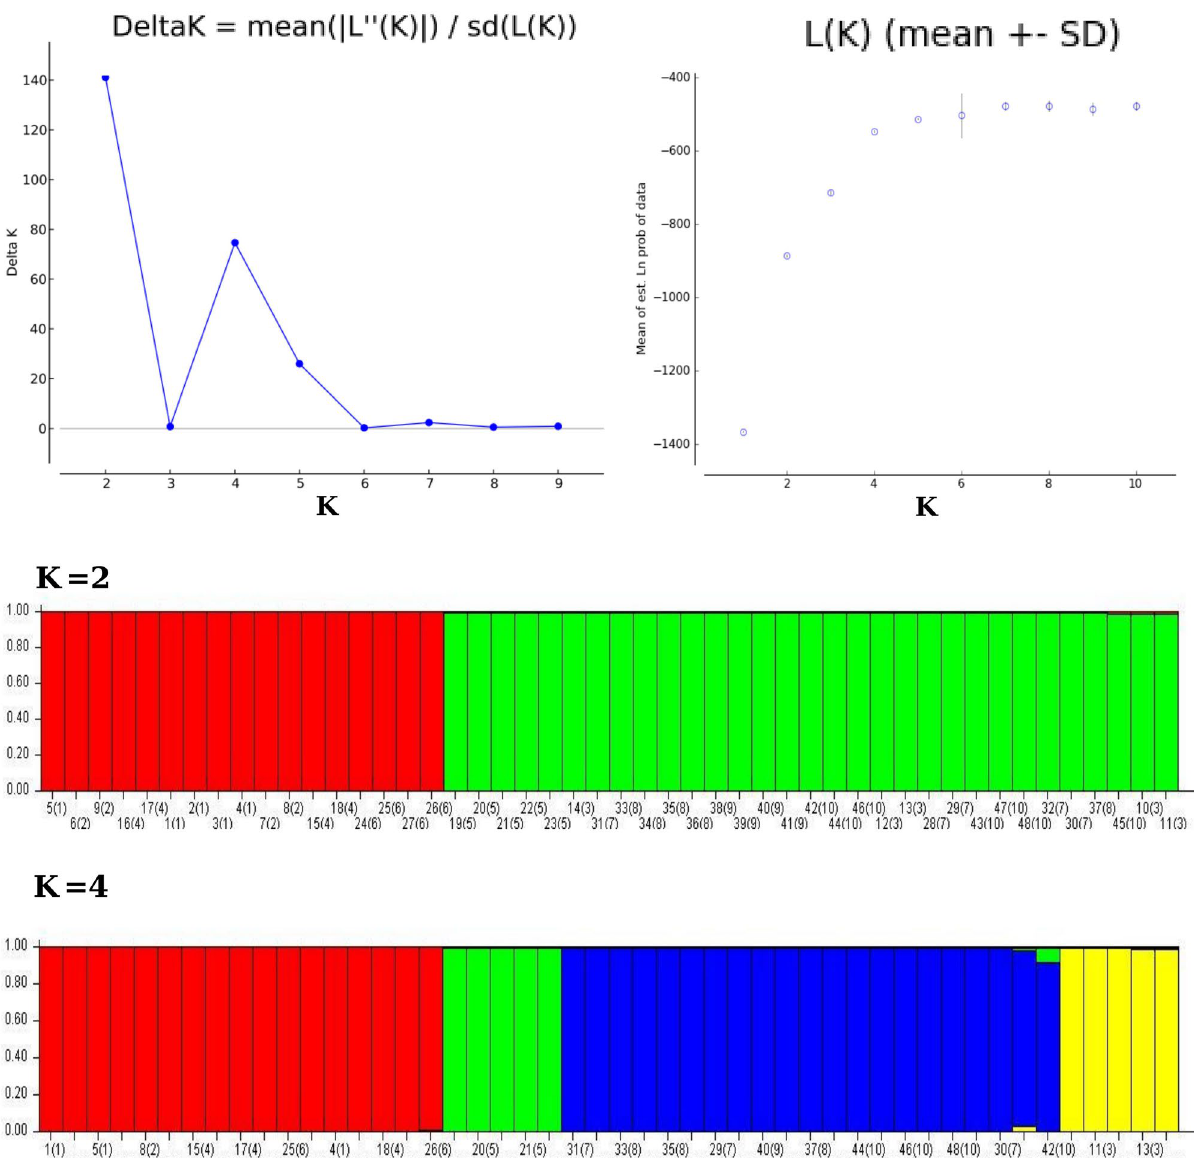
in parenthesis indicate populations and outside number are number of